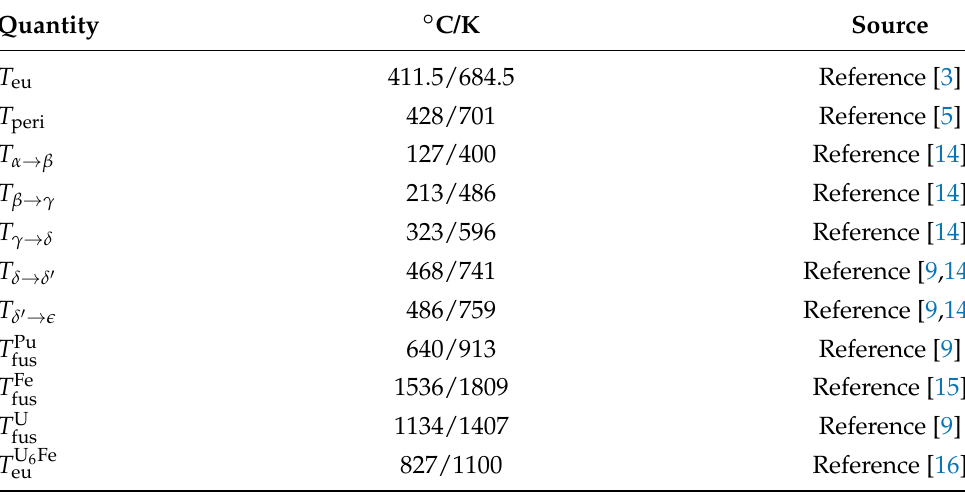
Table 1. Transition temperatures used in the reanalysis of Pu 6 Fe melt data.